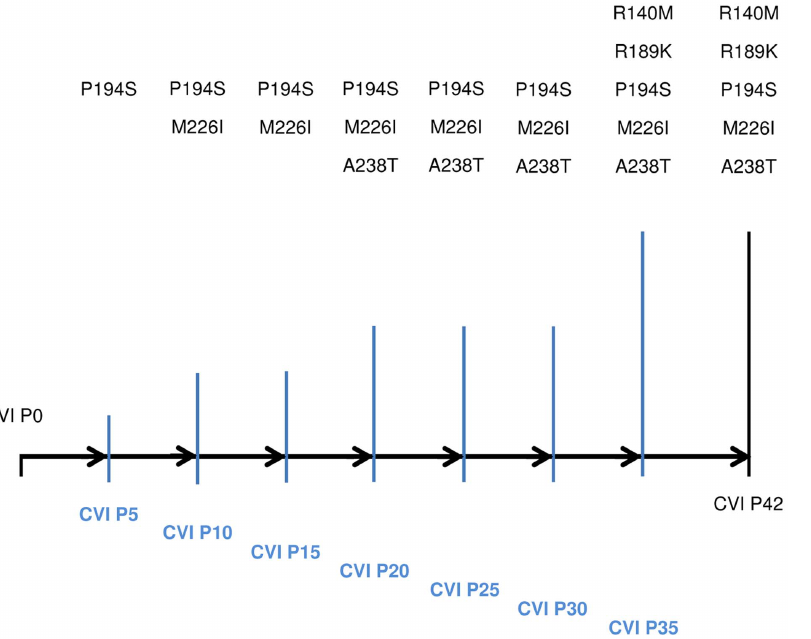
Figure 1. Amino acid mutations found in the HA of CVI passage isolates. Schematic representation of the mutations found in CVI passage isolates. The number of amino acid mutations increases with passage number and serum pressure. First mutations are found as early as Passage 5 and are carried over to later passages. Only two additional mutations were found between Passage 20 and Passage 42, indicating that most of the selection takes place in early passages. Black horizontal bar represents the progress of the passages. Blue vertical bars represent the time points where HA sequencing took place and their height represents the number of amino acid mutations found at each time point.